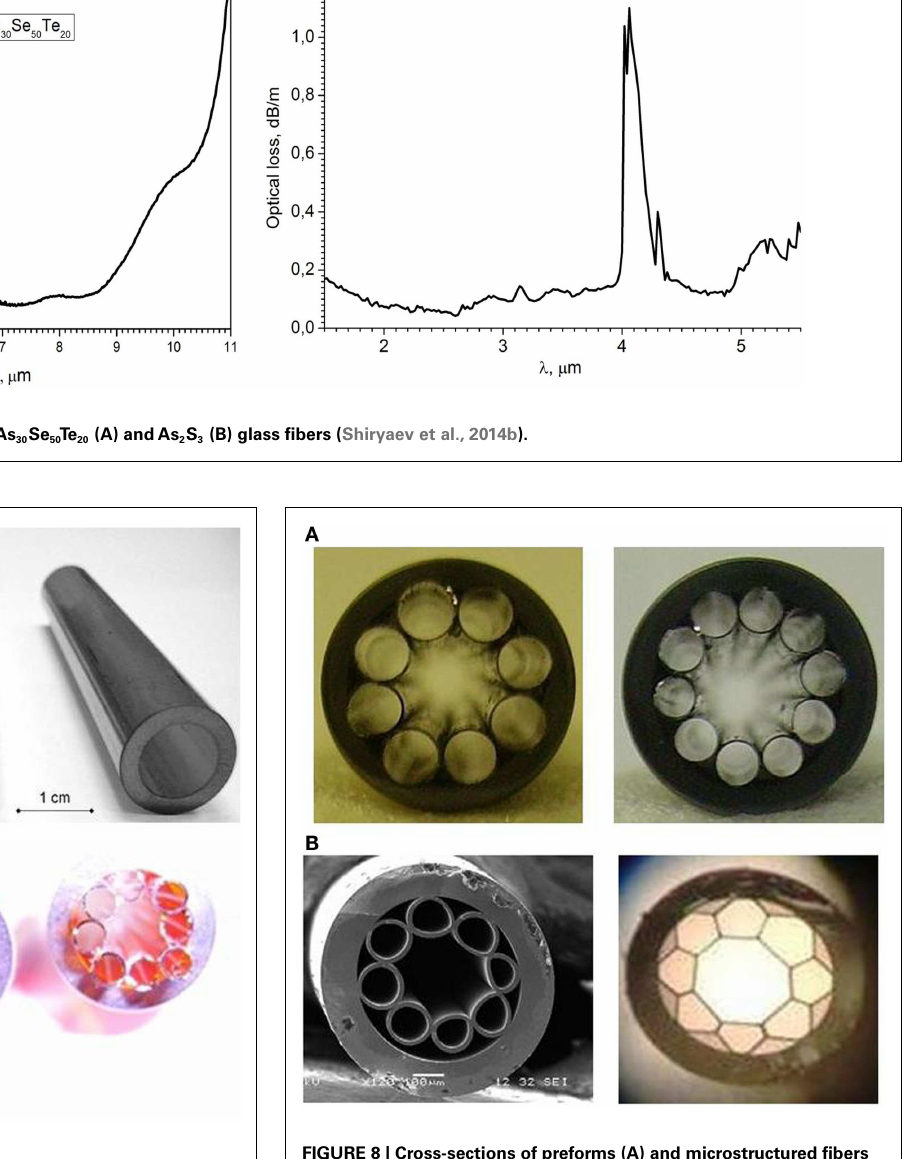
et al., 2015). It was carried out by the steady detachment